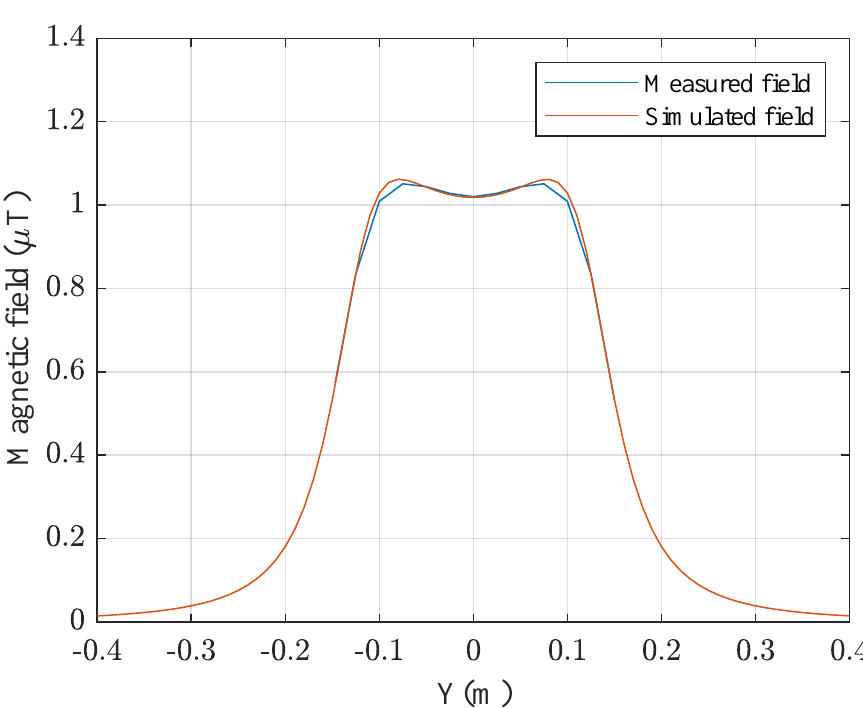
Figure 4. Magnetic field measured with ELT-400 and